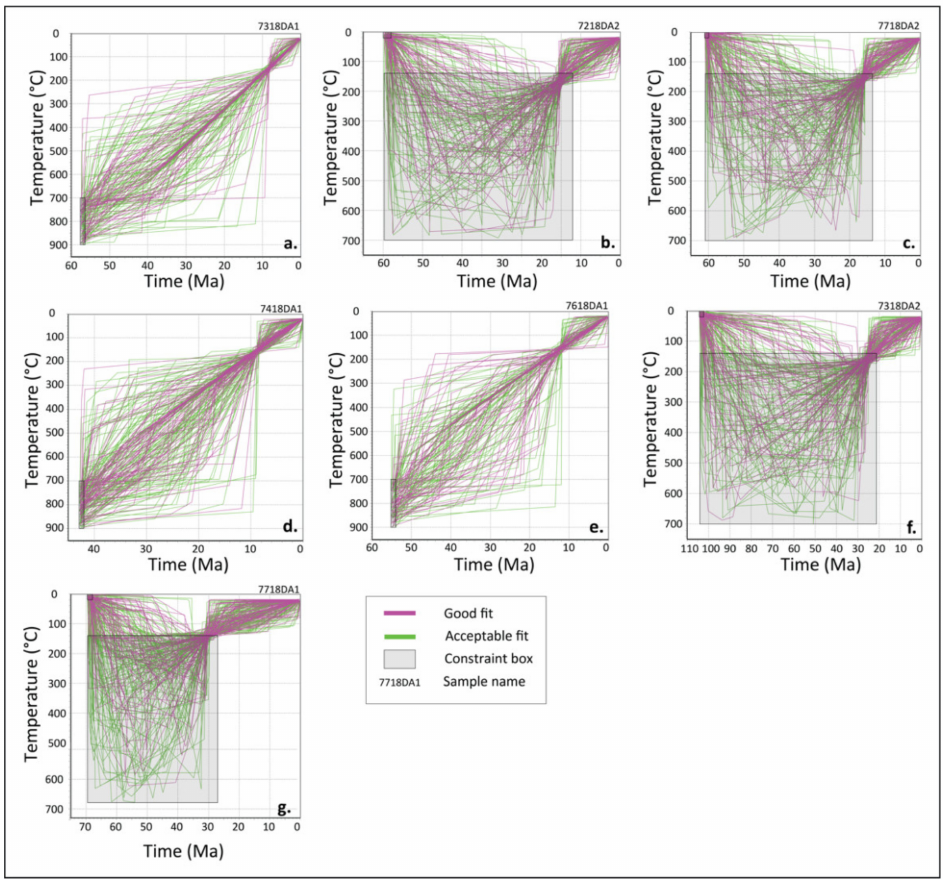
Figure 8. HeFTy [87] inverse modeling results for seven samples ( a – g ) displaying “good” (purple) and “acceptable” (green) time–temperature paths for each sample based on n = 10,000 model runs. Black boxes with gray shading represent geologic controls: For intrusive samples, U-Pb geochronology ages were used in conjunction with assumed zircon crystallization temperatures between 900–700 ◦ C to constrain path start points. For extrusive samples, U-Pb geochronology ages were used with the assumption that samples were erupted at surface conditions (0–25 ◦ C) to constrain path start points. Subsequent constraint boxes were implemented for extrusive samples because ZHe cooling ages require burial up to at least 140 ◦ (within the ZHe partial retention zone (PRZ)) following crystallization. All model runs require T-t paths to terminate at surface conditions (25 ◦ C) at 0 Ma. “Best fit” and “weighted mean” paths are not displayed to allow the viewer to better identify concentrations of “good-fit” path